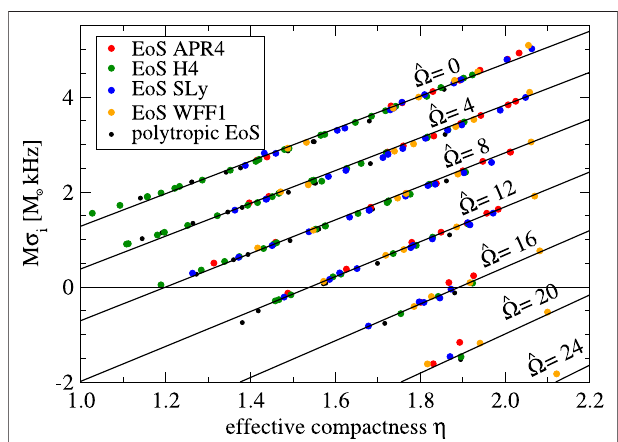
FIGURE 3 | The scaled f -mode frequency of the potentially unstable branch in dependence of the effective compactness for different values of ^ Ω (cid:1) (cid:2) M Ω /kHz. The straight lines represent the prediction of our fi tting formula, cf. Equation 12 . Figure taken from Krüger and Kokkotas (2020a) with permission by APS.